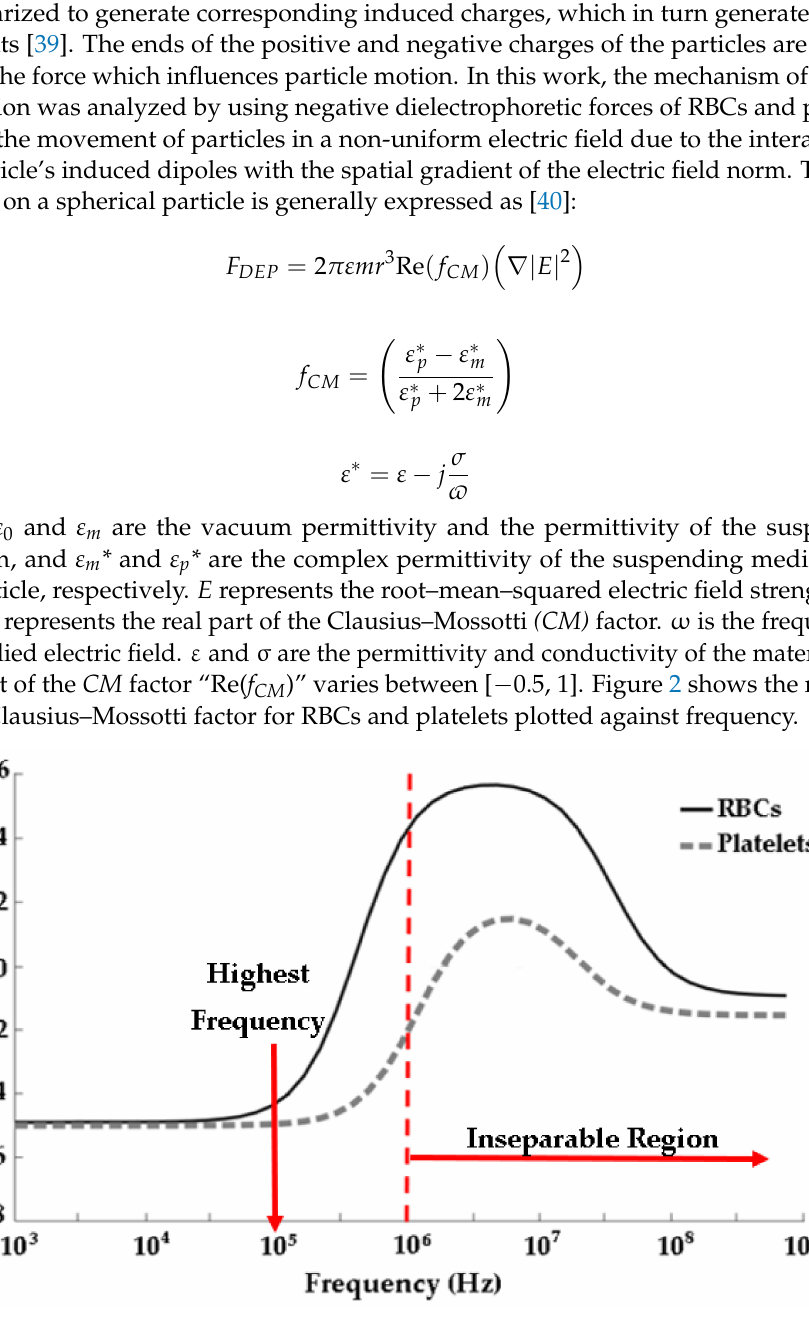
Figure 2. Plot of the real part of the Clausius–Mossotti factor for RBCs and platelets in a medium with a conductivity of 55 mS/m, using a single-shell model with the parameters found in the literature [41]. An RBC cell consists of cytoplasm surrounded by a membrane. RBCs and platelets can be considered a single-shell model rather than homogeneous spheres, as shown in the schematic provided in Figure 3